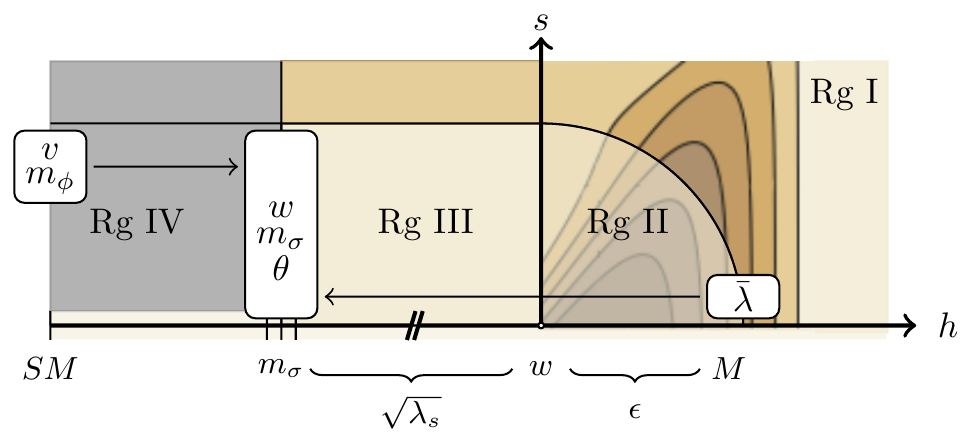
Figure 2 . Schematic construction of the RG-improved e(cid:11)ective potential in case of large scale separation v (cid:28) m (cid:27) (cid:28) w as described in the text. Heavy fermions that are integrated out at (cid:22) UV (cid:24) M lead to higher dimensional operators e.g. (cid:22) (cid:21) h 4 s 8 =M 8 (which is the operator of the same dimension as the b quark mass term). (cid:22) (cid:21) also runs, mainly due to the one-loop contribution by the bottom quarks, which we take into account. For scales below m (cid:27) the new physics direction is ignored, and the resummation of logs can be performed the same way as in the SM. We de(cid:12)ne the free parameters of the model at the scales shown in the picture. The scale separation between the p di(cid:11)erent mass scales in the FN mechanism is set by (cid:21) s and (cid:15) . The di(cid:11)erent regions in the e(cid:11)ective potential landscape are described in the